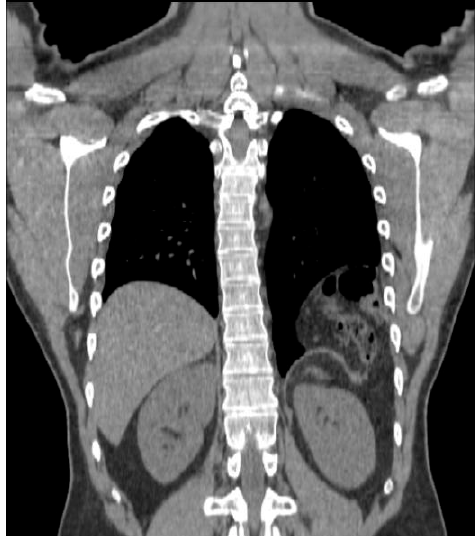
Figure 1. CT scan (performed in 2018) showing the recurrent left posterolateral hernia.